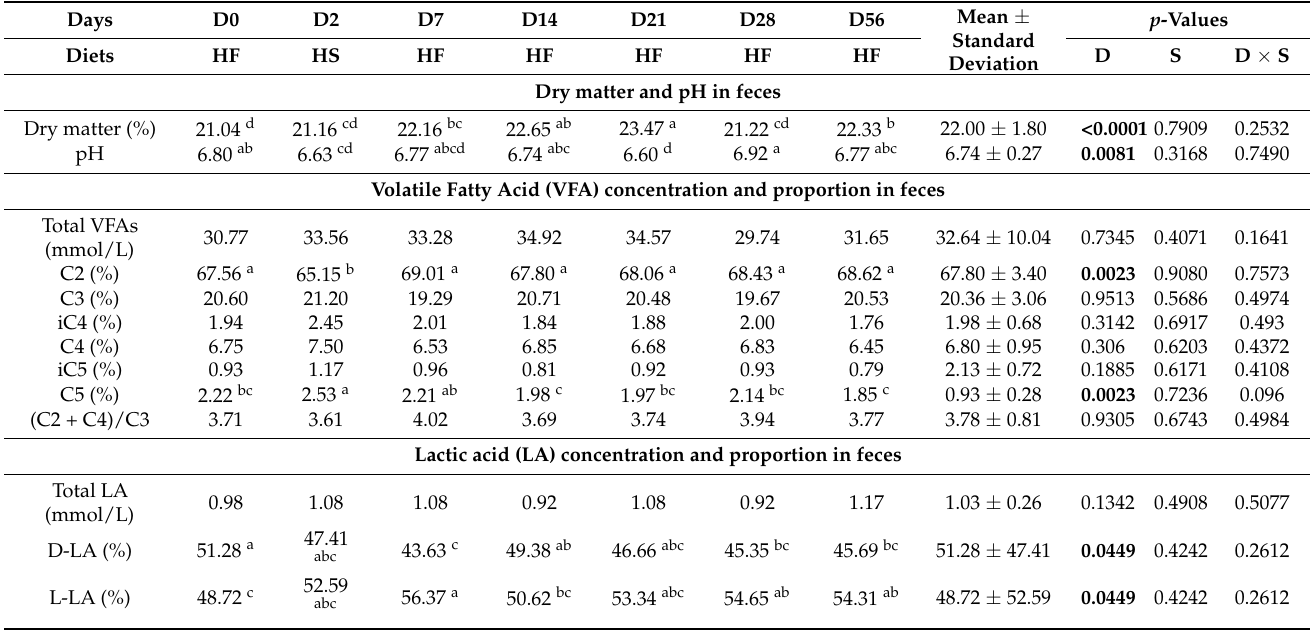
Table 3. Effect of the day (D) on the parameters of microbial activity in the feces during two consecutive dietary changes from high-fiber (HF) to high-starch (HS) diet and vice